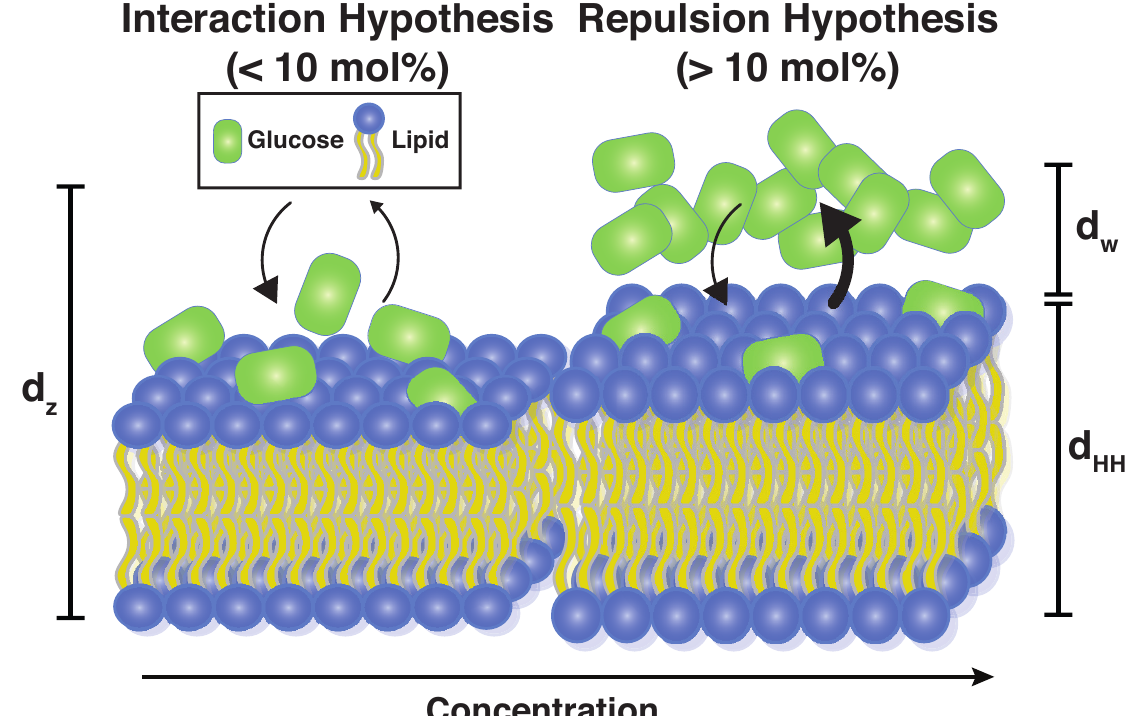
Figure 1. Current models of sugar-bilayer action suggests favorable, enthalpy-driven interactions dominate at lower sugar concentrations (the interaction hypothesis) while repulsive, entropy-driven effects dominate at higher concentrations (the repulsion hypothesis) [15]. d z denotes the lamellar membrane spacing, d HH the membrane thickness, and d w the thickness of the hydration water